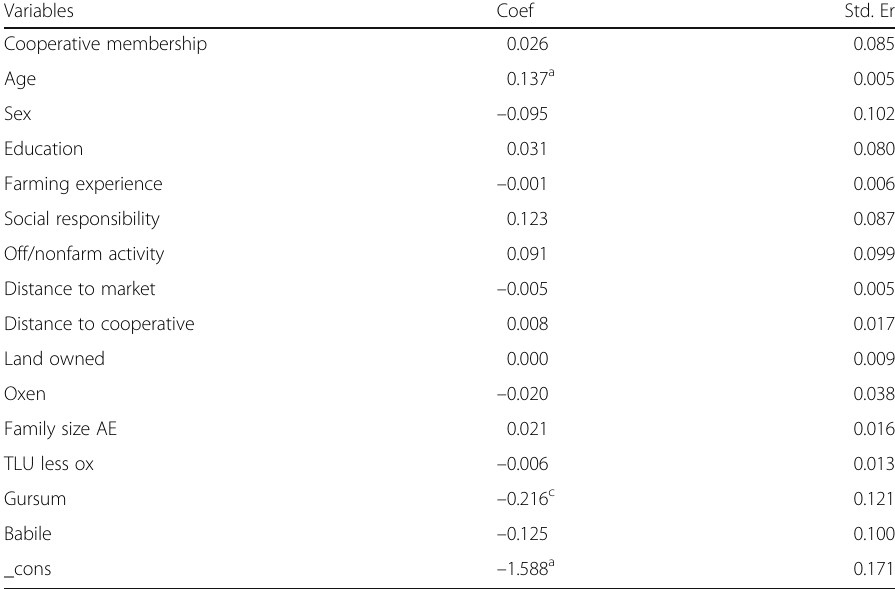
Table 8 Result of the placebo